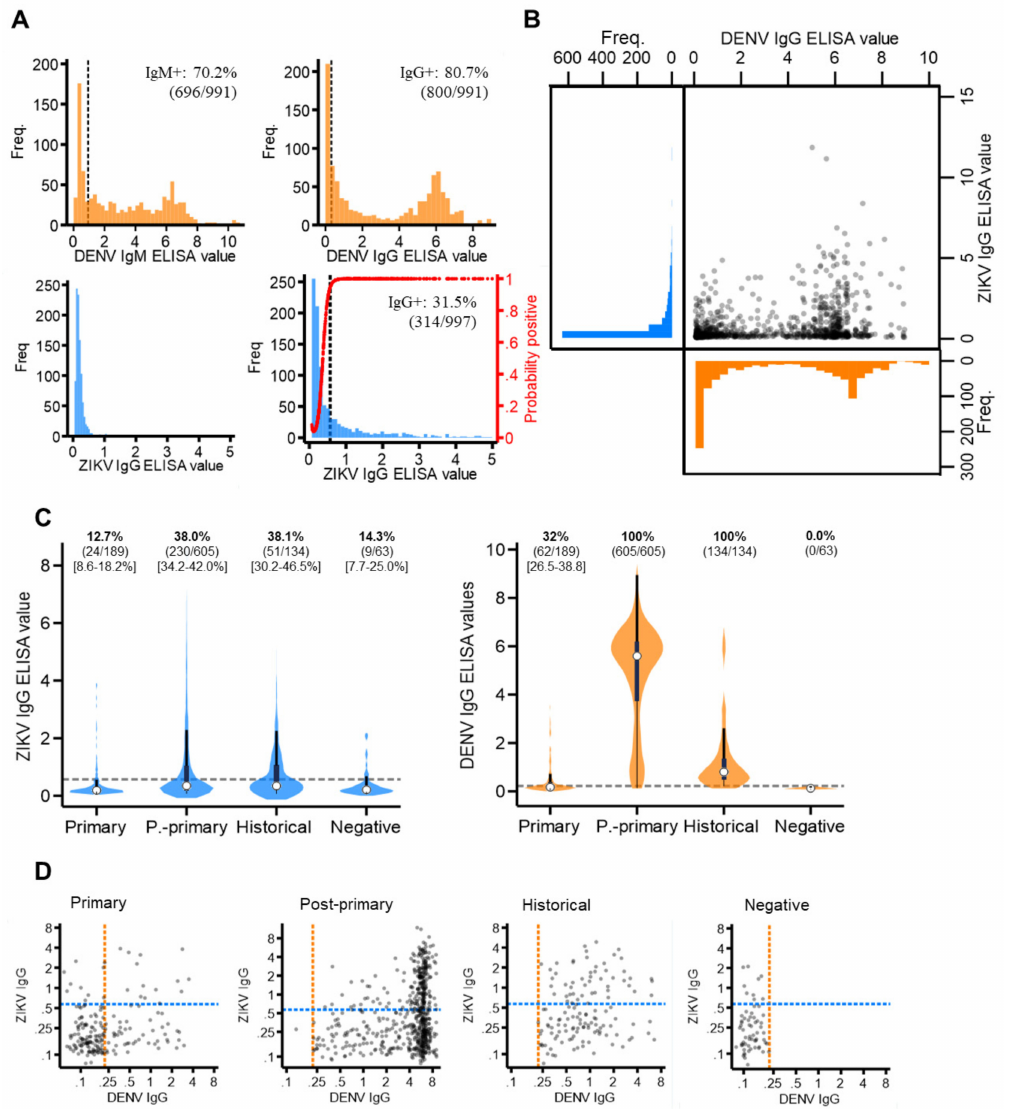
Figure 2. ZIKV and DENV antibody responses among the study population. ( A ) Distribution of ZIKV and DENV IgM and IgG antibody responses (ELISA values) among the study population. Red line: probability of being ZIKV IgG seropositive according to the mixture model. ( B ) Scatterplot of ZIKV versus DENV IgG ELISA values among the study population. ( C ) Violin plots of ZIKV and DENV IgG ELISA values among those classified as DENV primary, post-primary, historical and negative. White circles: median, thick black bar: IQR. Grey dash: IgG seroprevalence thresholds (ZIKV IgG: 0.57 ELISA values, DENV IgG: 0.22 ELISA values). ( D ) Scatterplots of ZIKV versus DENV IgG ELISA values among DENV primary, post-primary, historical and negative cases plotted on a log scale. Orange dash: DENV IgG seroprevalence threshold (0.22 ELISA values). Blue dash: ZIKV IgG seroprevalence threshold (0.57 ELISA